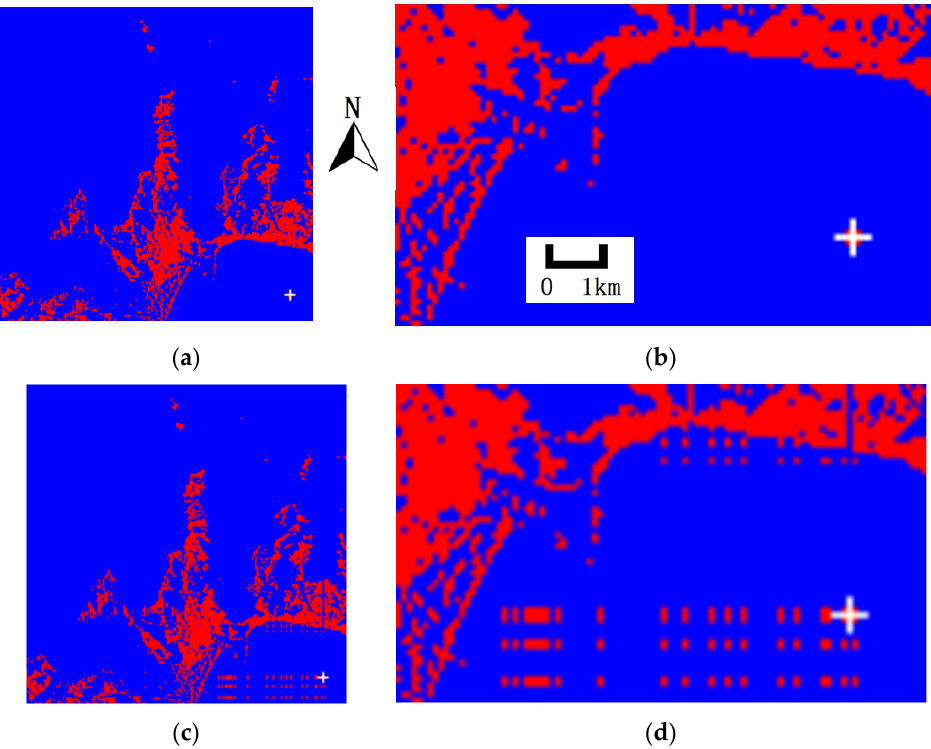
Figure 9. The viewshed results of the viewpoint at row 183, column 185 on the DEM of Malaga, Spain by different algorithms. Observer is marked with a white cross. Red area is visible and blue area is invisible. ( a ) R3, while a totally same result by every cell is figured out using HiPDERL; ( b ) Part of ( a ), row 140–200, column 100–200; ( c ) HiPDERL; ( d ) Part of ( c ), row 140–200, column